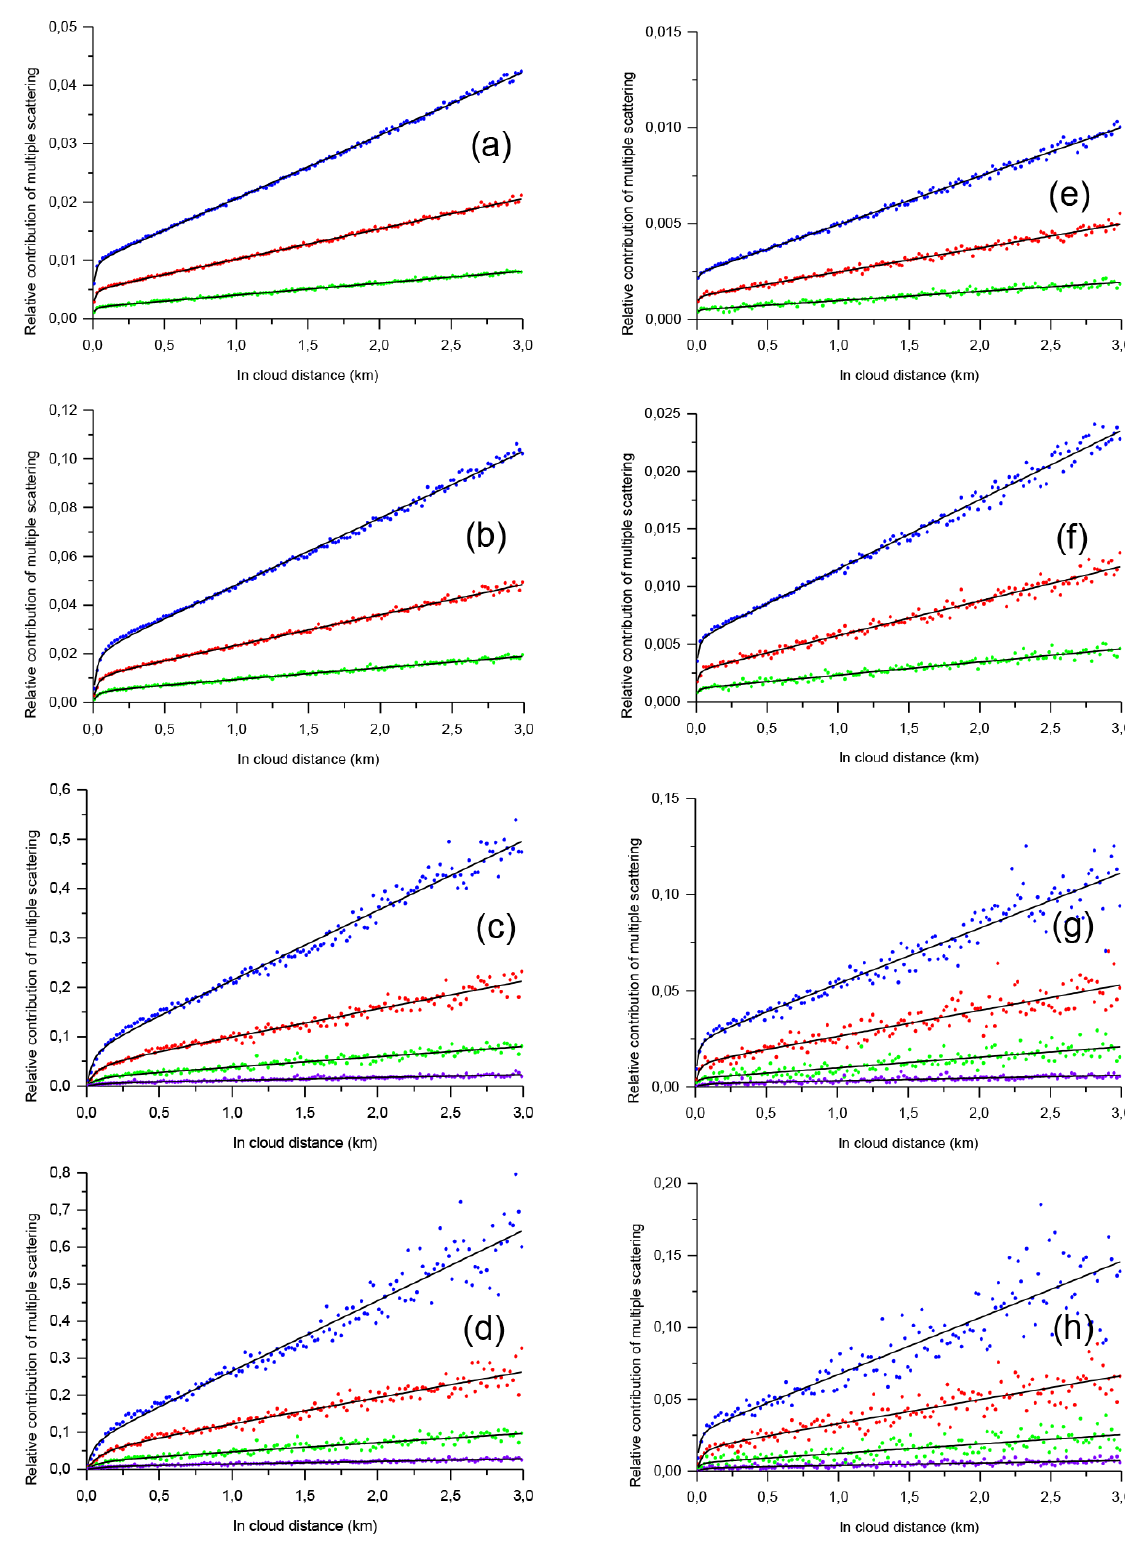
Figure 5. Multiple-scattering contributions R MSto1 to lidar signals. Points – MC simulations, black lines – fitting with the empirical model. The full RFOV is 1.0mrad (a–d) and 0.25mrad (e–h) . Coarse aerosol (a, e) , water cloud (b, f) , JS cirrus (c, g) , Ci cirrus (d, h) . The extinction coefficient is 1.0km − 1 (blue points), 0.5km − 1 (red points), 0.2km − 1 (green points), and 0.06km − 1 (purple points). The distance to the cloud base is